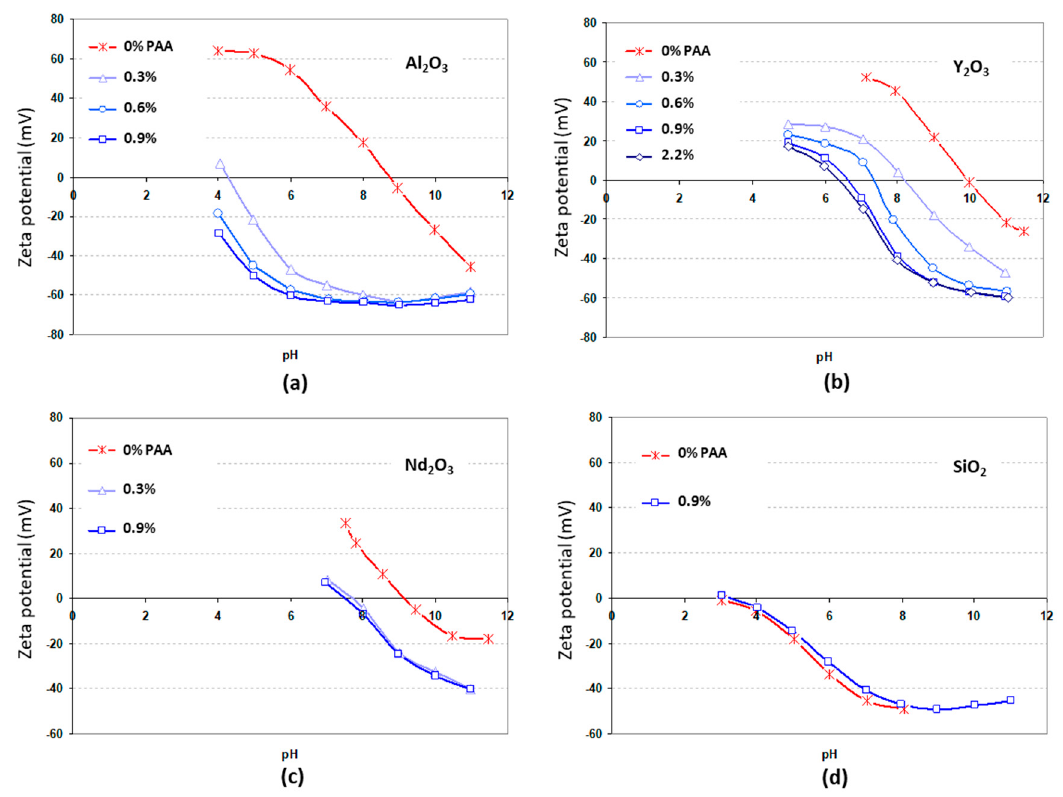
Figure 2. Evolution of the zeta potential of primary oxide (Al 2 O 3 , Y 2 O 3 , Nd 2 O 3 , and SiO 2 ) aqueous suspensions as a function of the pH.( a ) Al 2 O 3 ( b ) Y 2 O 3 ; ( c ) Nd 2 O 3 ; ( d ) SiO 2 .